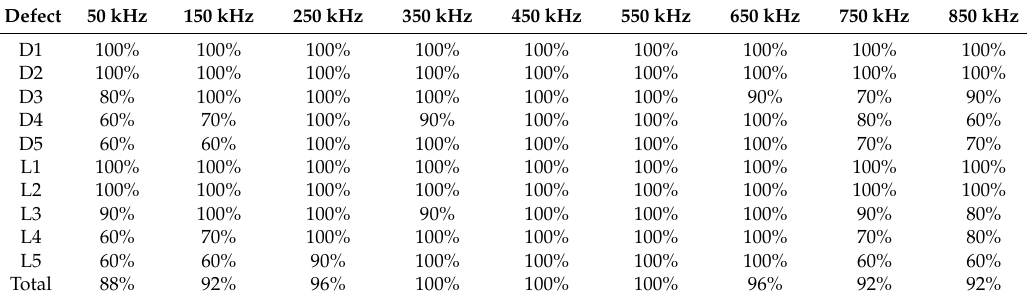
Table 2. Classification accuracy for each defect at different